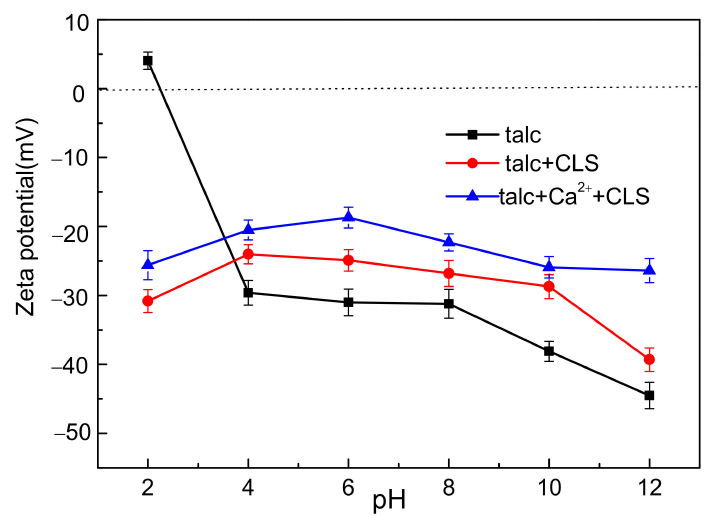
Figure 8. Effect of CLS on zeta potential values of talc with/without the presence of Ca 2+ ions (c(CLS) = 200 mg/L).